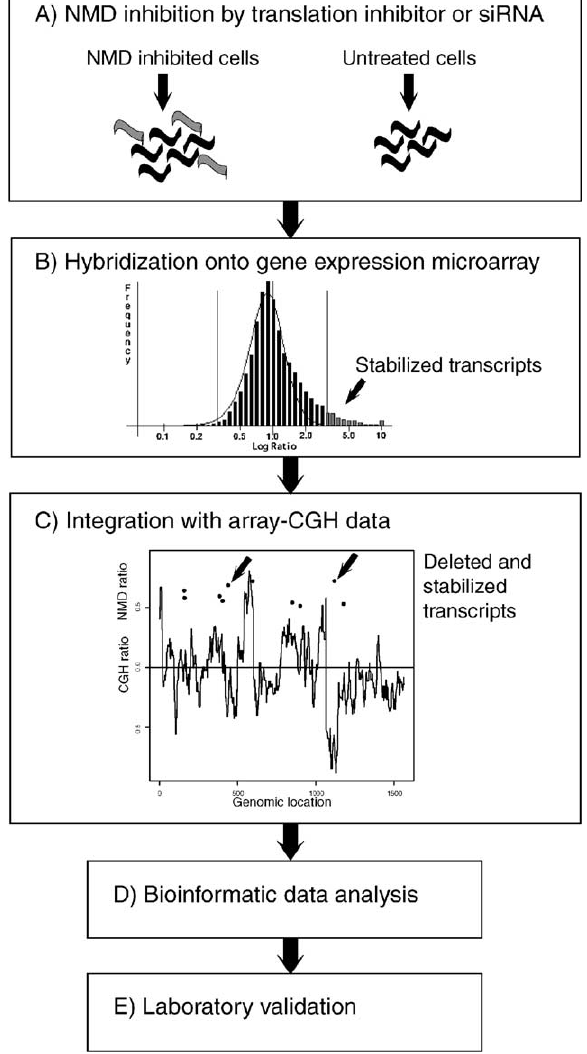
Fig. 1. Schematic workflow for NMD microarray-based screening: (A) NMD pathway can be blocked by using translation inhibitors or siRNAs against key NMD pathway components. Reference cells are left untreated. (B) After RNA isolation, reverse transcription and labeling of the two RNA populations with different fluorescent dyes, gene expression microarray analysis is carried out and stabilized transcripts are identified. (C) CGH microarrays are used to determine deleted loci from the same sample. Integration with NMD inhibition data allows pinpointing both stabilized and deleted genes from the data set. (D) Lists of candidate genes are prioritized using bioinformatic data analysis. This includes filtering out physiologic NMD substrates and common stabilized genes due to drug or siRNA treatment unrelated to mutation status. (E) Truncating mutations or alternative splicing of the selected genes are verified from the studied samples, and the clinical relevance of the detected alterations are determined from patient